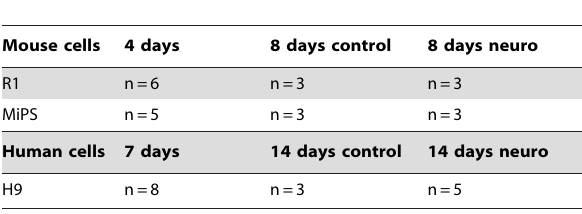
Table 1. Number of irradiated embryoid bodies per group.